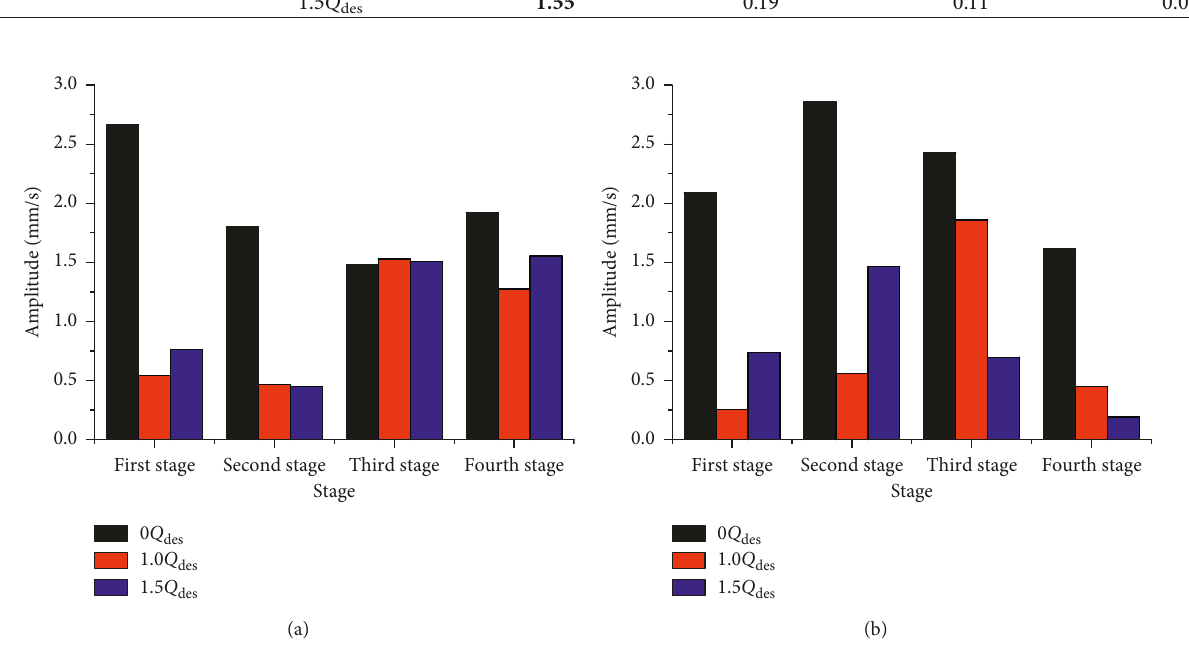
Figure 9: Vibration on each stage under (a) BPF and (b)